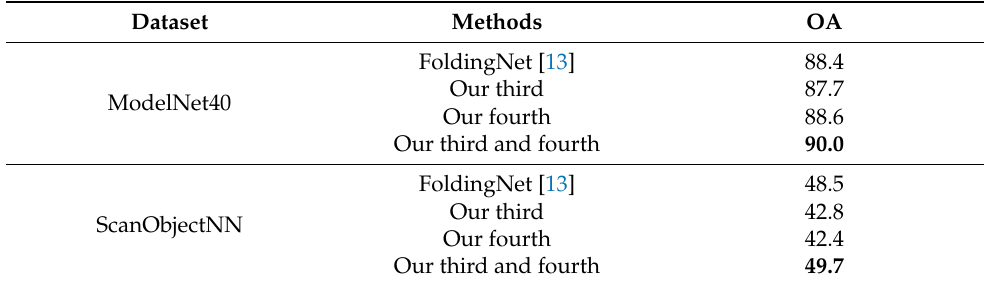
Table 3. Classification results on ModelNet40 and ScanObjectNN using a linear support vector machine